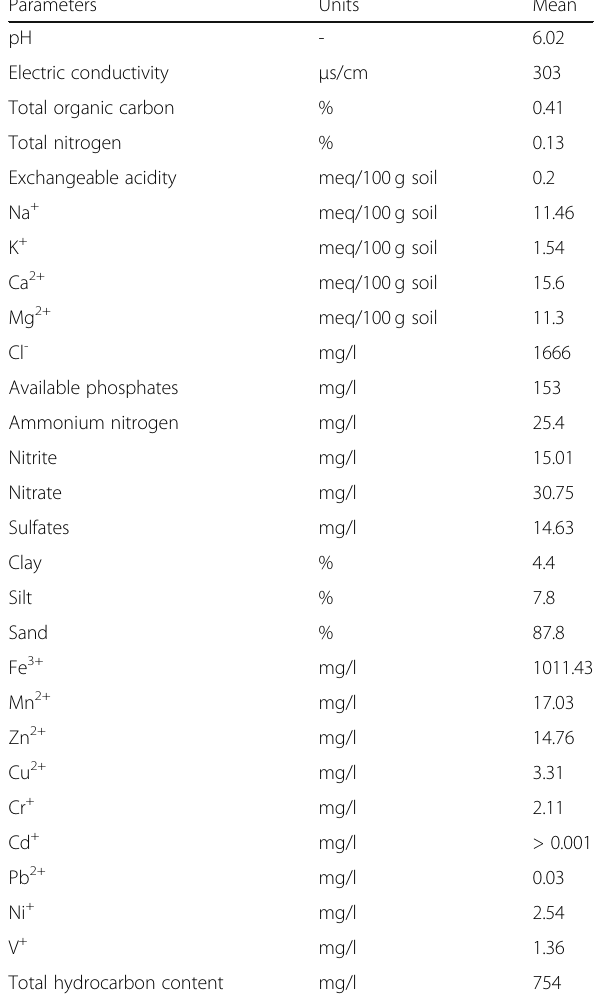
Table 1 Physicochemical properties of planting soil